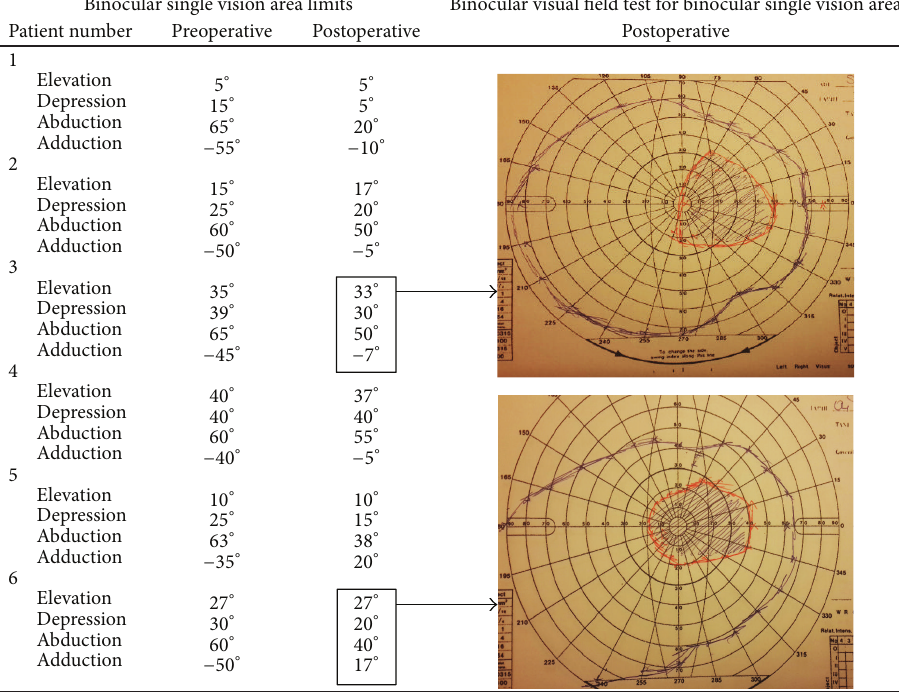
Figure 3: Preoperative, postoperative binocular single vision area limits and binocular visual field test for binocular single vision area of patients number 3 and number 6. Goldman kinetic visual field test results are shown with the black arrows for patients number 3 and number 6. All patients gained a new area of binocular single vision in the primary position after the operation. Also the binocular single vision areas are enlarged for all patients like what is shown for patients number 3 and number